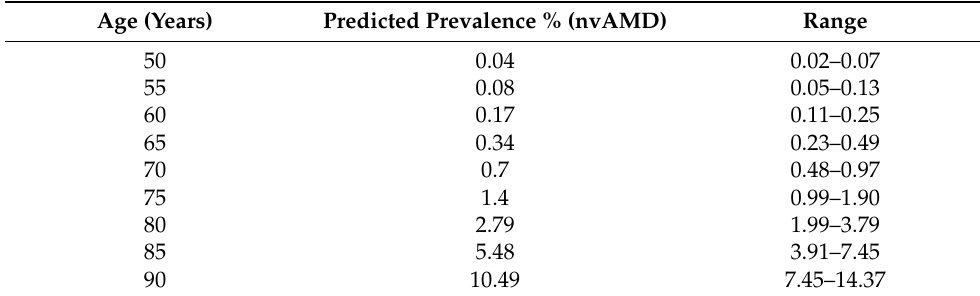
Table 1. Estimated prevalence according to age and neovascular age-related macular degeneration (nvAMD) in populations of European